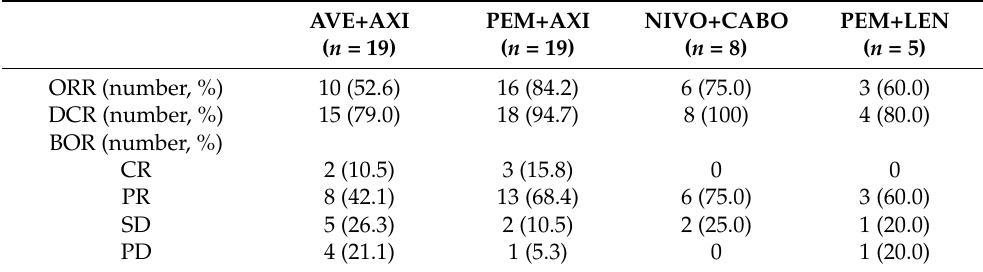
Table 2. The treatment effect in patients who received immune checkpoint inhibitor and tyrosine kinase inhibitor.